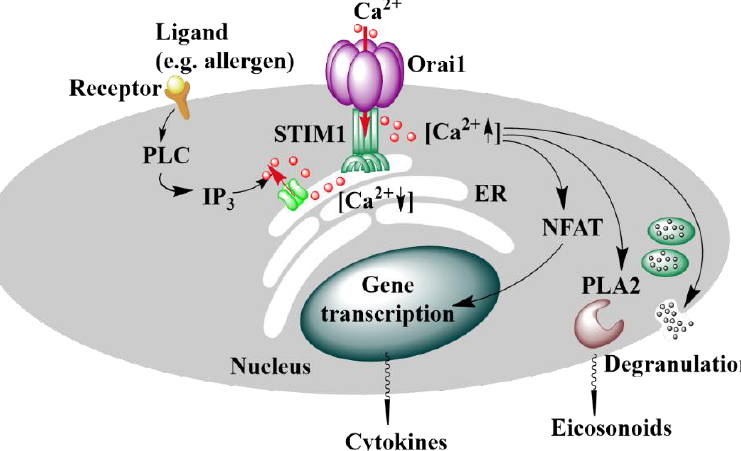
Figure 1. The CRAC channel activation pathway and downstream signaling processes. The scheme represents the activation pathways in the mast cell subsequent to the binding of a ligand to a receptor at the extracellular side. Activation of phospholipase C and generation of IP 3 leads to store-depletion, activation of STIM1 and subsequent STIM1 / Orai1 coupling. Ca 2 + influx that occurs upon Orai1 opening mediates downstream signaling cascades that can lead to gene transcription or release of inflammatory mediators such as histamines, eicosanoids, and cytokines.